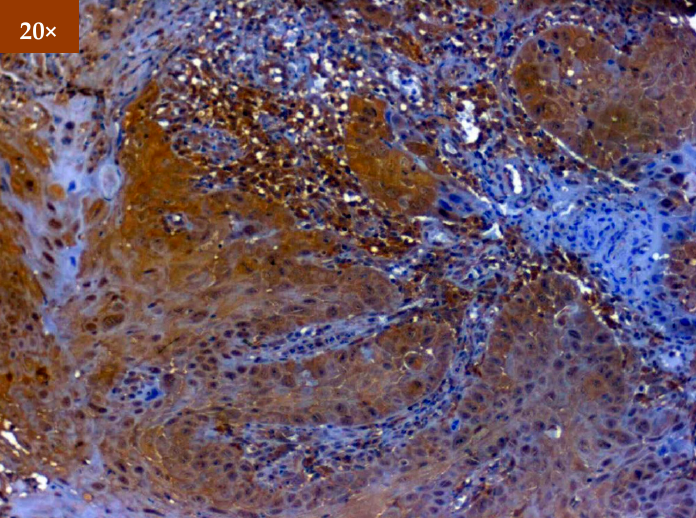
Figure 5. IHC for EGFR in dysplasia (under 20× magnification) .